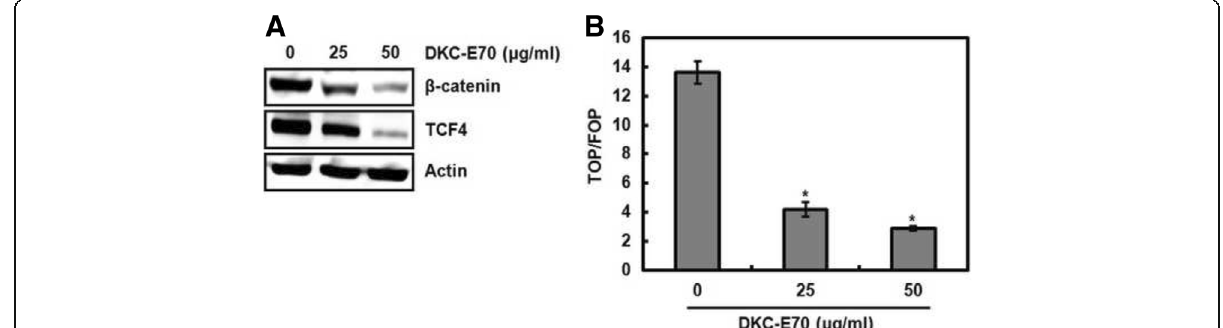
Fig. 6 Decreased level of cyclin D1 mRNA by DKC-E70 is attributed to the inhibition of Wnt activation. a HCT116 cells were treated with DKC-E70 at the indicated concentrations for 24 h. Cell lysates were subjected to SDS-PAGE and the Western blot was performed using antibodies against β -catenin or TCF4. Actin was used as internal control for Western blot analysis. b HCT116 cells were co-transfected with TOP-FLASH or FOP-FLASH constructs containing wild-type or mutated TCF binding sites and pRL-null. The cells were treated with DKC-E70 for 24 h. Luciferase activity for TOP-FLASH and FOP-FLASH was measured as a ratio of firefly luciferase signal/renilla luciferase signal using a dual luciferase assay